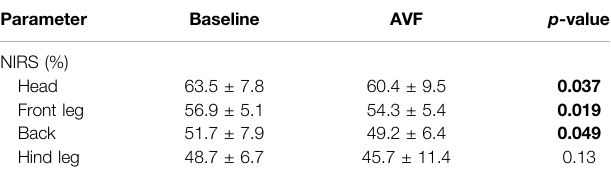
TABLE 2 | Changes in tissue perfusion and oxygenation after AVF opening.